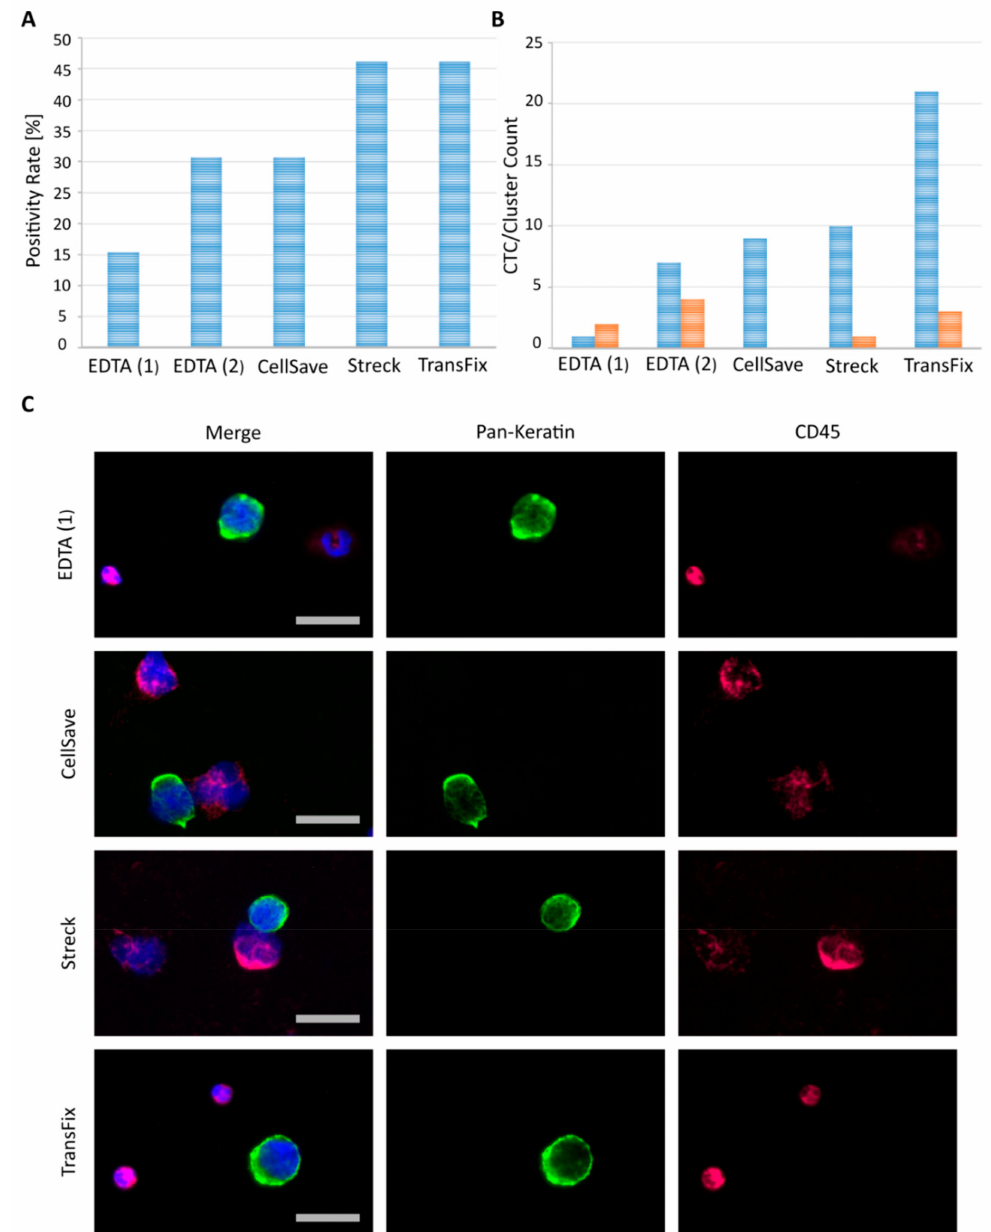
Figure 3. Comparison of blood collection tubes in clinical patient samples drawn and processed in parallel. EDTA (1) indicates samples were processed by the 99 mbar separation protocol, while EDTA (2) samples were run using the reduced 50 mbar Parsortix ® protocol. Fixed samples were stored for 24 h following blood draw and separated using the high pressure Parsortix ® protocol (99 mbar). All samples were subsequently cytospun and stained by fluorescent antibodies against and DAPI (blue). ( A ) Percentage of CTC-positive patients (defined as ≥ 1 CTC per 7.5 mL of blood) across the 14 cancer patients tested. ( B ) Blue bars: Overall single CTC count detected in the 14 cancer patients tested in parallel for each collection tube. Orange bars: Amount of CTC clusters ( ≥ 2 directly attached CTCs) detected in the 14 cancer patients tested in parallel for each collection tube. ( C ) Representative CTC and leukocyte images from selected index patients within our cohort. Images were taken manually with a standard fluorescence microscope at 40 × magnification. Size bars equal 20 µ